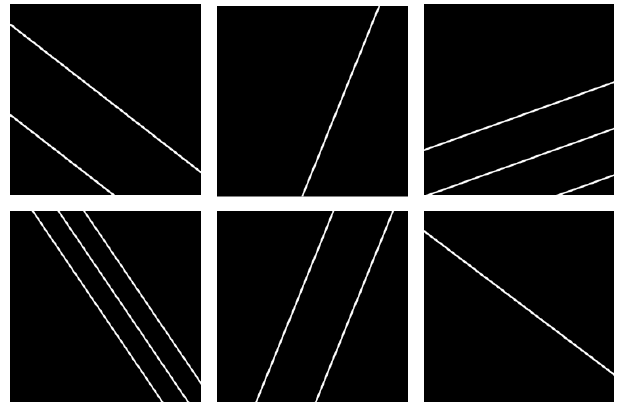
Figure 4. Examples of pseudo-line dataset.